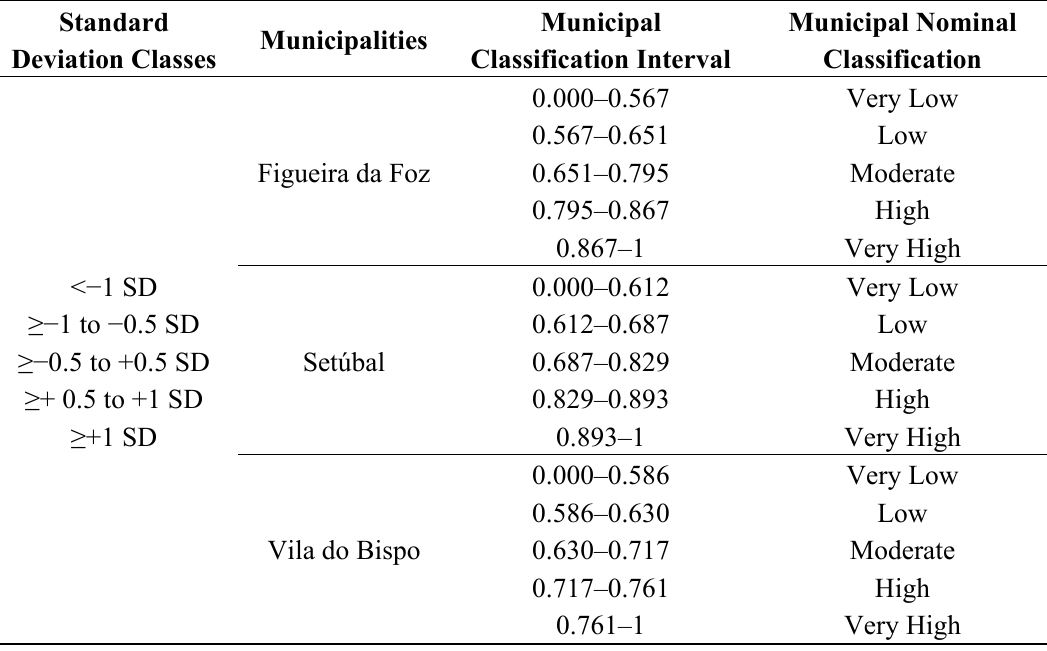
Table 4. Social vulnerability